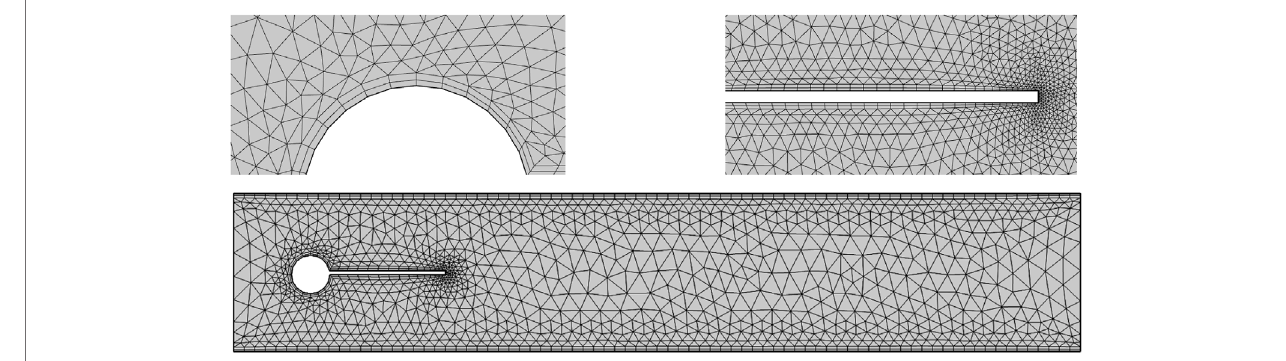
FIGURE 4 | Hybrid mesh grid detail.